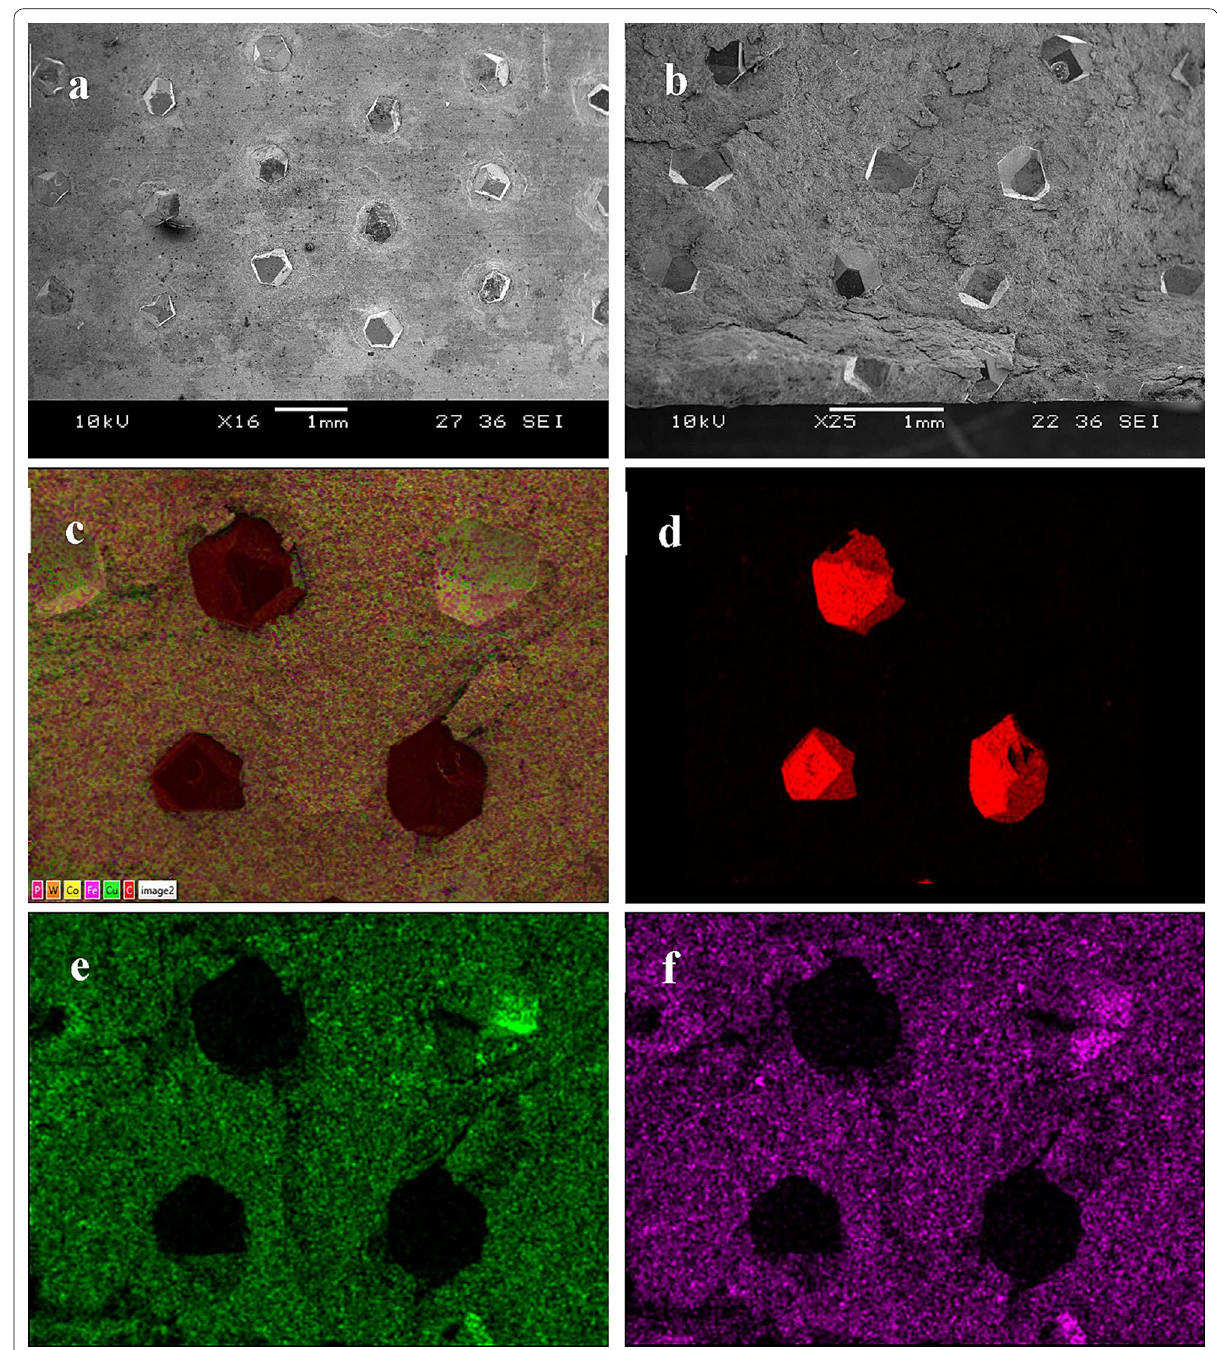
Figure 8 Microstructure of the segment with 3D lattice of diamond grits: a surface of the green segment; b cross-sectional surface of the green segment; c EDS hierarchical image of b ; d EDS of C from c ; e EDS of Cu from c ; f EDS of Fe from